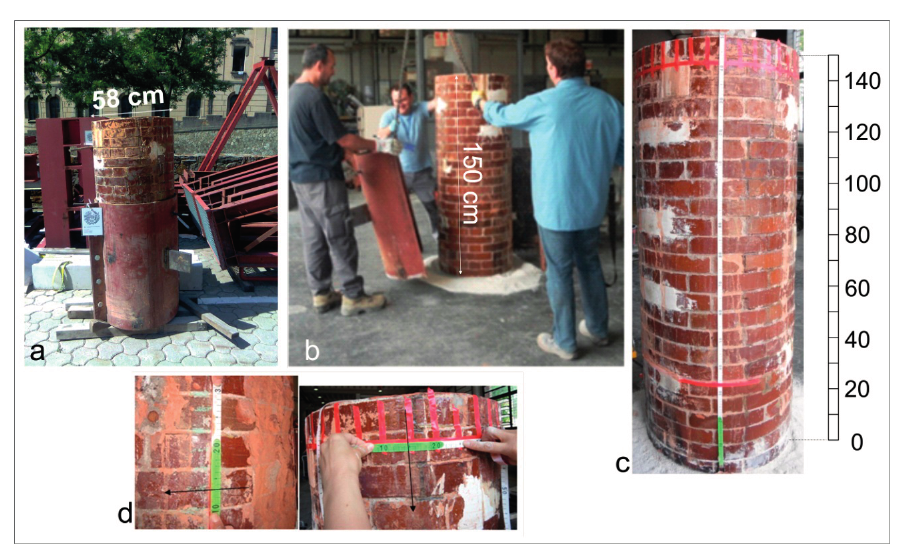
Figure 2. Preparing the specimen for the test. ( a ) The column with the metallic jacket; ( b ) the test site; ( c ) the column prepared to be tested; ( d ) the distance between horizontal and vertical radar